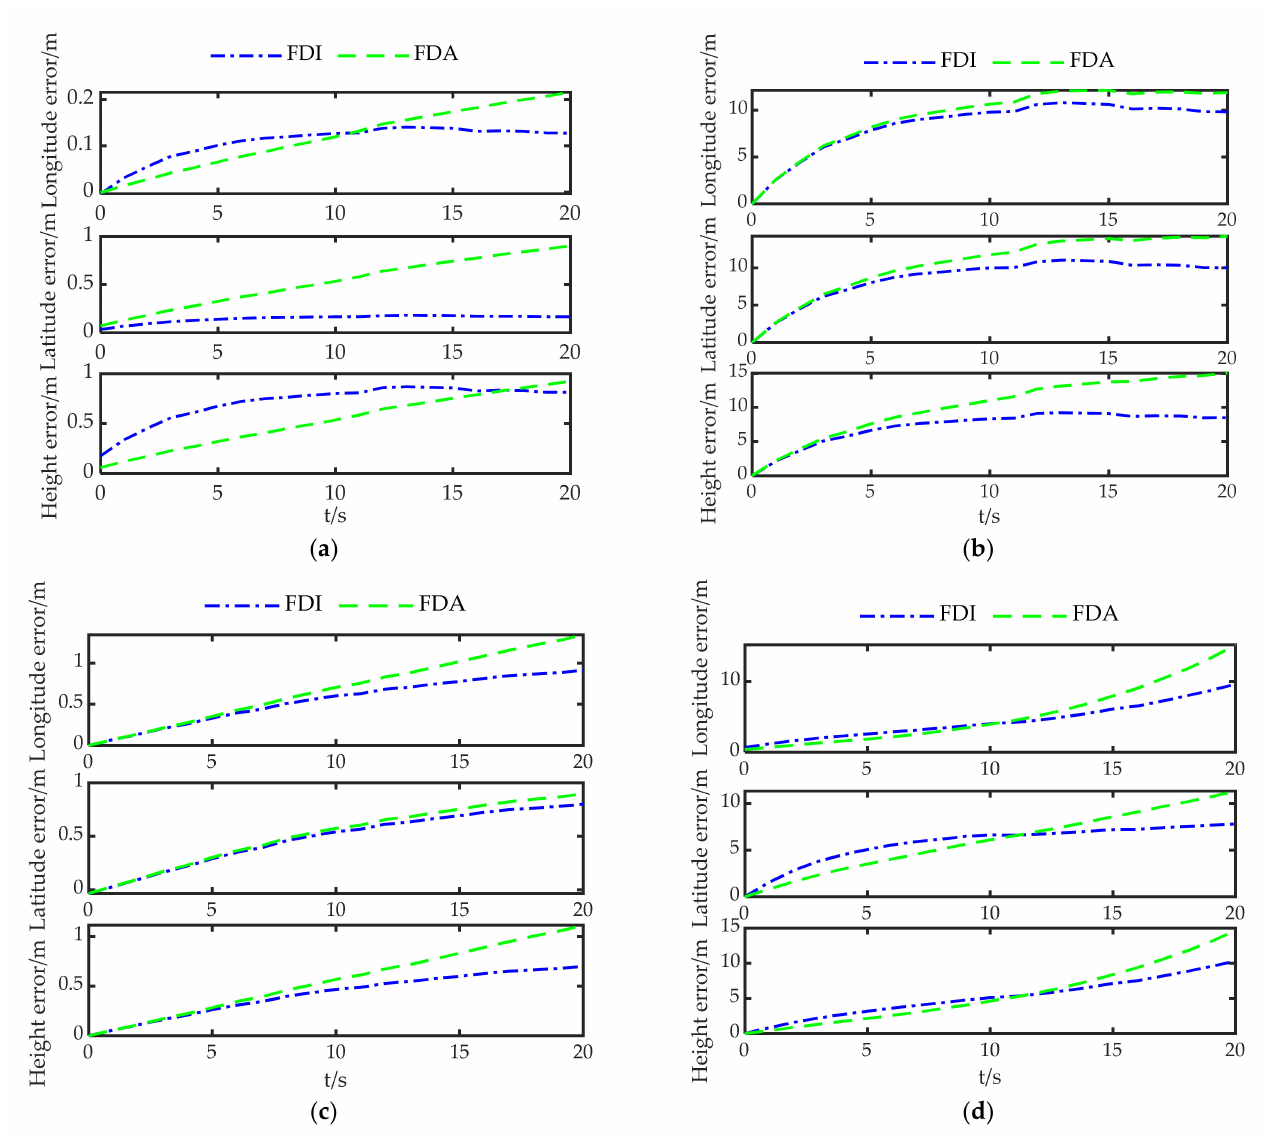
Figure 8. Positioning errors in each environment during the fault. ( a – d ) are the positioning errors under Env1, Env2, Env3 and Env4,